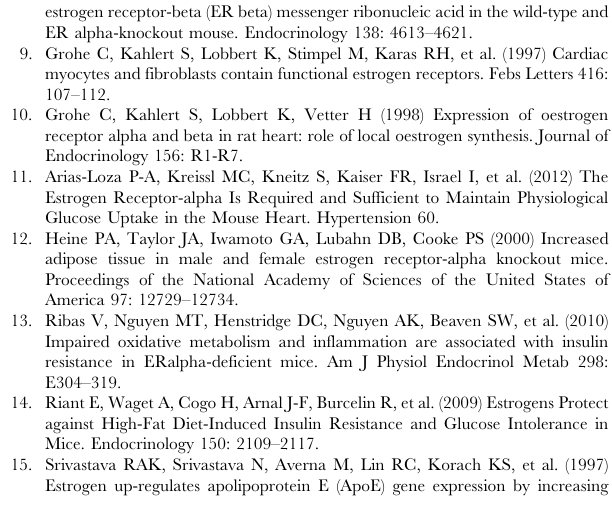
Figure S1 Hierarchical Cluster analysis of genotype significant genes from cardiac mRNA microarray re- sults. mRNA expression patterns were established for cardiac tissue from both male and female, ER a 2 / 2 and wild type mice. HCL analysis was performed on intensity data using partek genomic suites for the significant gene list. FDR (0.05) corrected genes with a p value of 0.05 or less were considered significant. Figure S2 Hierarchical Cluster analysis of sex signifi- cant genes from cardiac mRNA microarray results. mRNA expression patterns were established for cardiac tissue from both male and female, ER a 2 / 2 and wild type mice. HCL